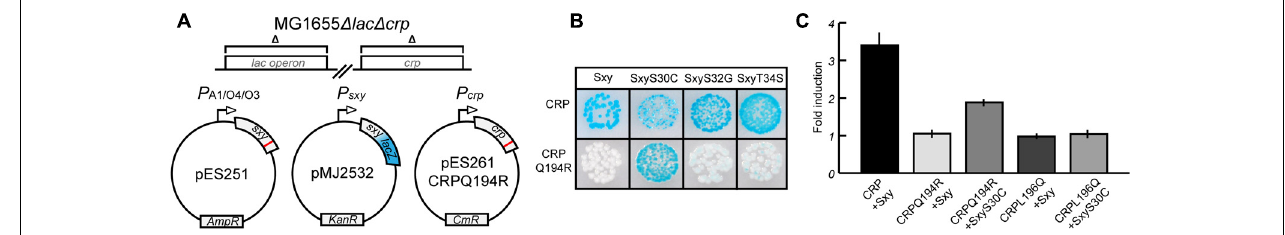
FIGURE 2 | Isolation of Sxy mutants that suppress the inability of CRP(Q194R) to induce CRP-S promoters. (A) Schematic overview of the experimental setup. The sxy coding sequence was mutated by error-prone PCR and cloned into pMG25 creating pES251 and mutants were screened in MG1655 (cid:49) lac (cid:49) crp cells (Jaskolska and Gerdes, 2015) carrying plasmids pMJ2532 (Jaskolska and Gerdes, 2015) and pES261CRPQ194R (for CRP Q194R production). The LacZ reporter in pMJ2532 (blue color) was used to assess activation of Sxy dependent promoters. (B) Phenotypes of suppressor Sxy mutants. Sxy S30C shows strong activation of the reporter while S32G and T34S have slightly higher activity than wild-type (WT) Sxy. (C) Quantification of suppression by Sxy S30C using a P sxy :yfp reporter. Sxy S30C activates the CRP-S promoter in the presence of CRP Q194R but not of CRP L196Q. The quantifications ± 1 SD are the result of three biological replicates as described in the section “Materials and Methods.”